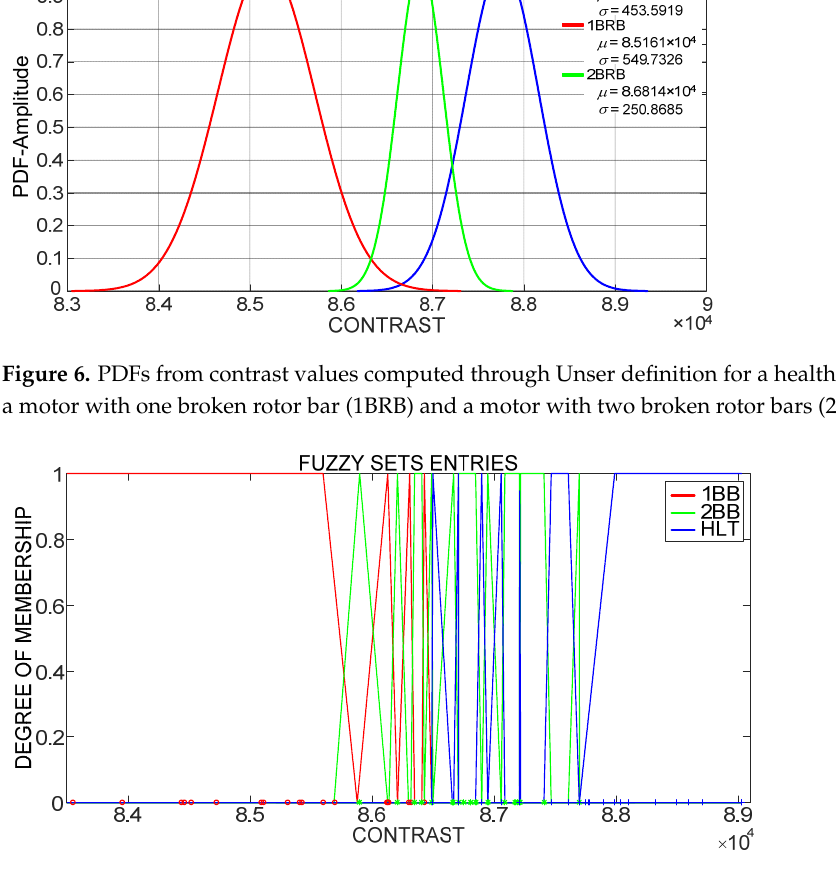
Figure 7. Fuzzy set entries based on Unser definition of contrast.